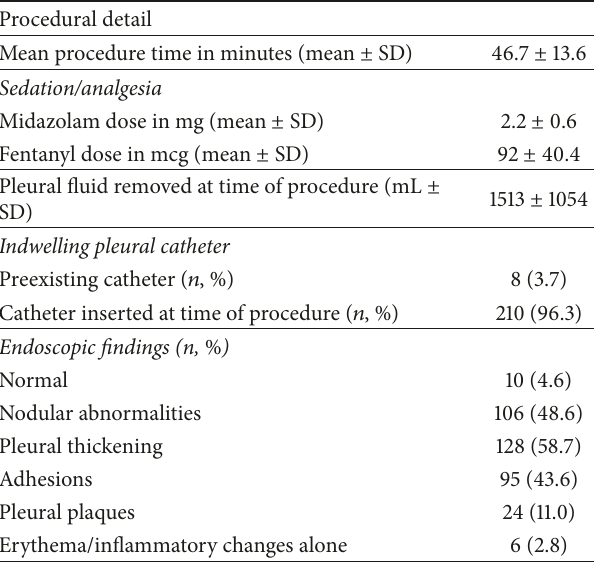
Table 1: Patient characteristics. Table 2: Procedural